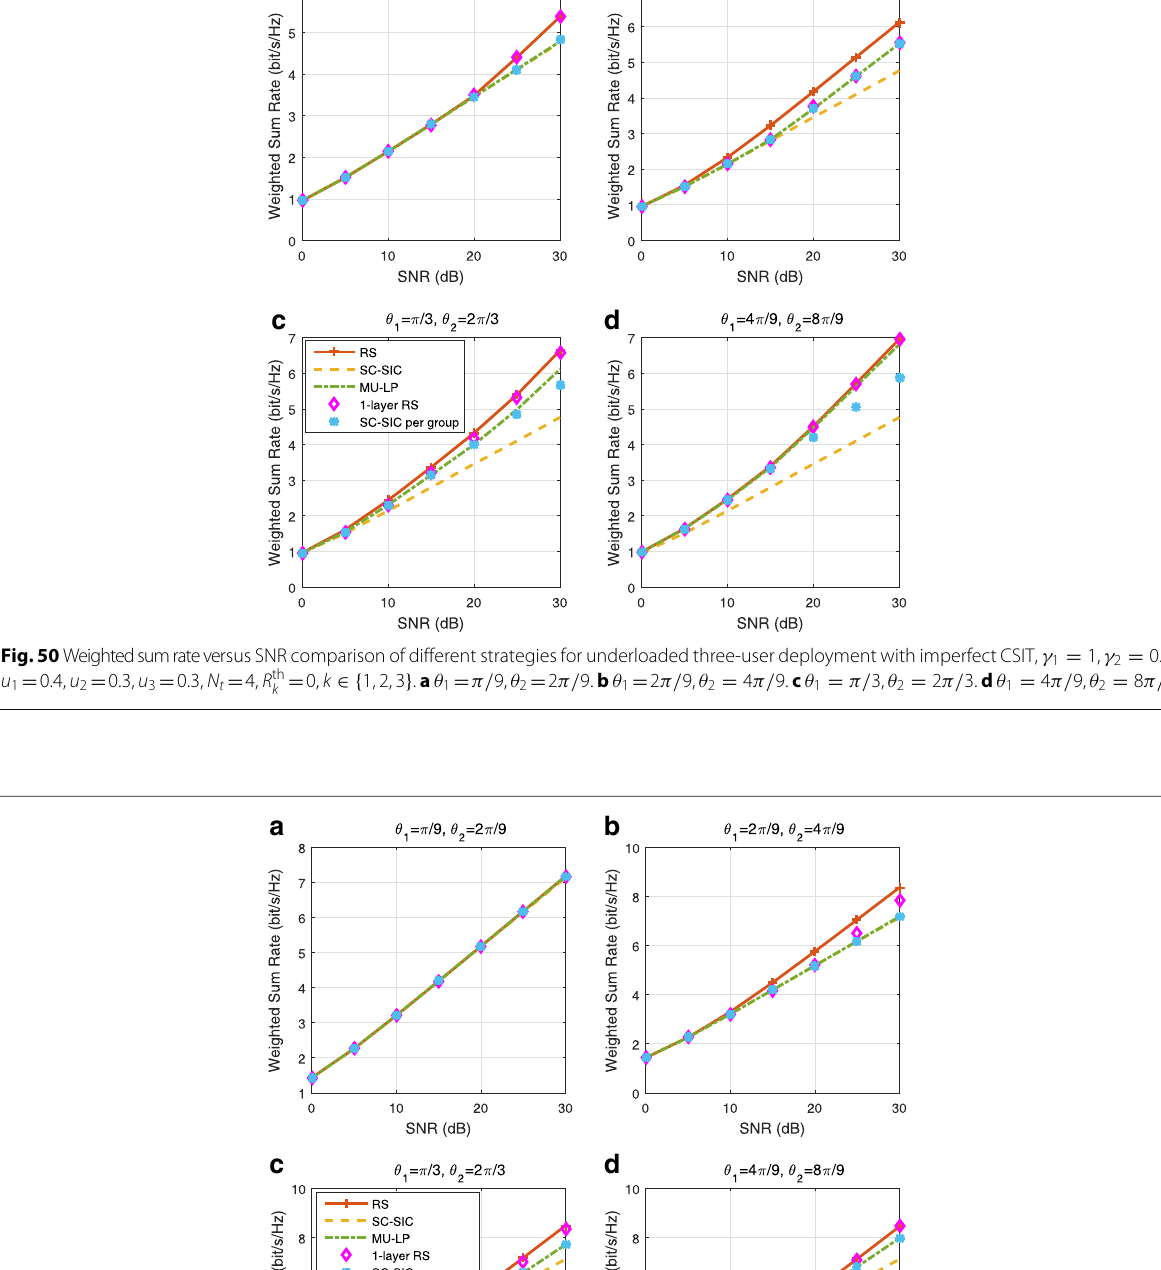
= 0, k ∈ { 1,2,3 } . a θ k